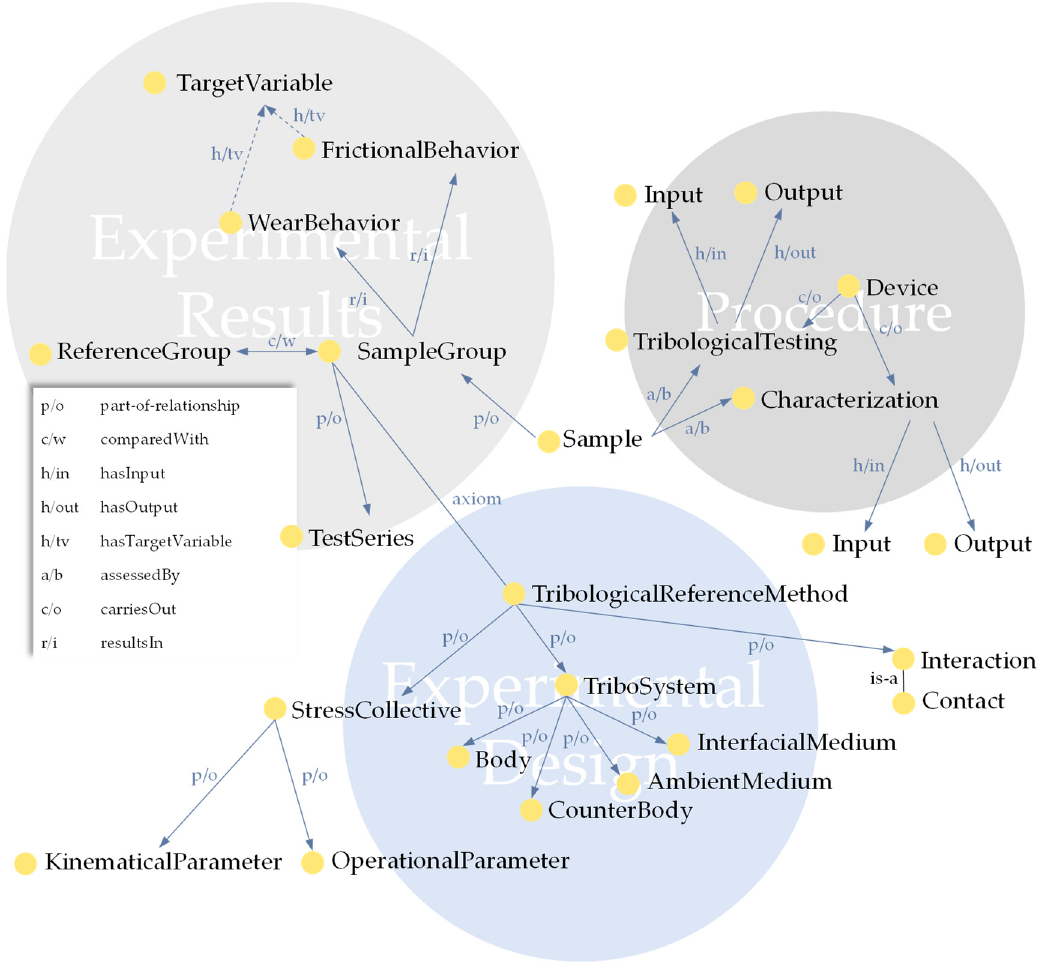
Figure 6. Core concepts yellow circles) and relationships (blue arrows) of tribAIn.